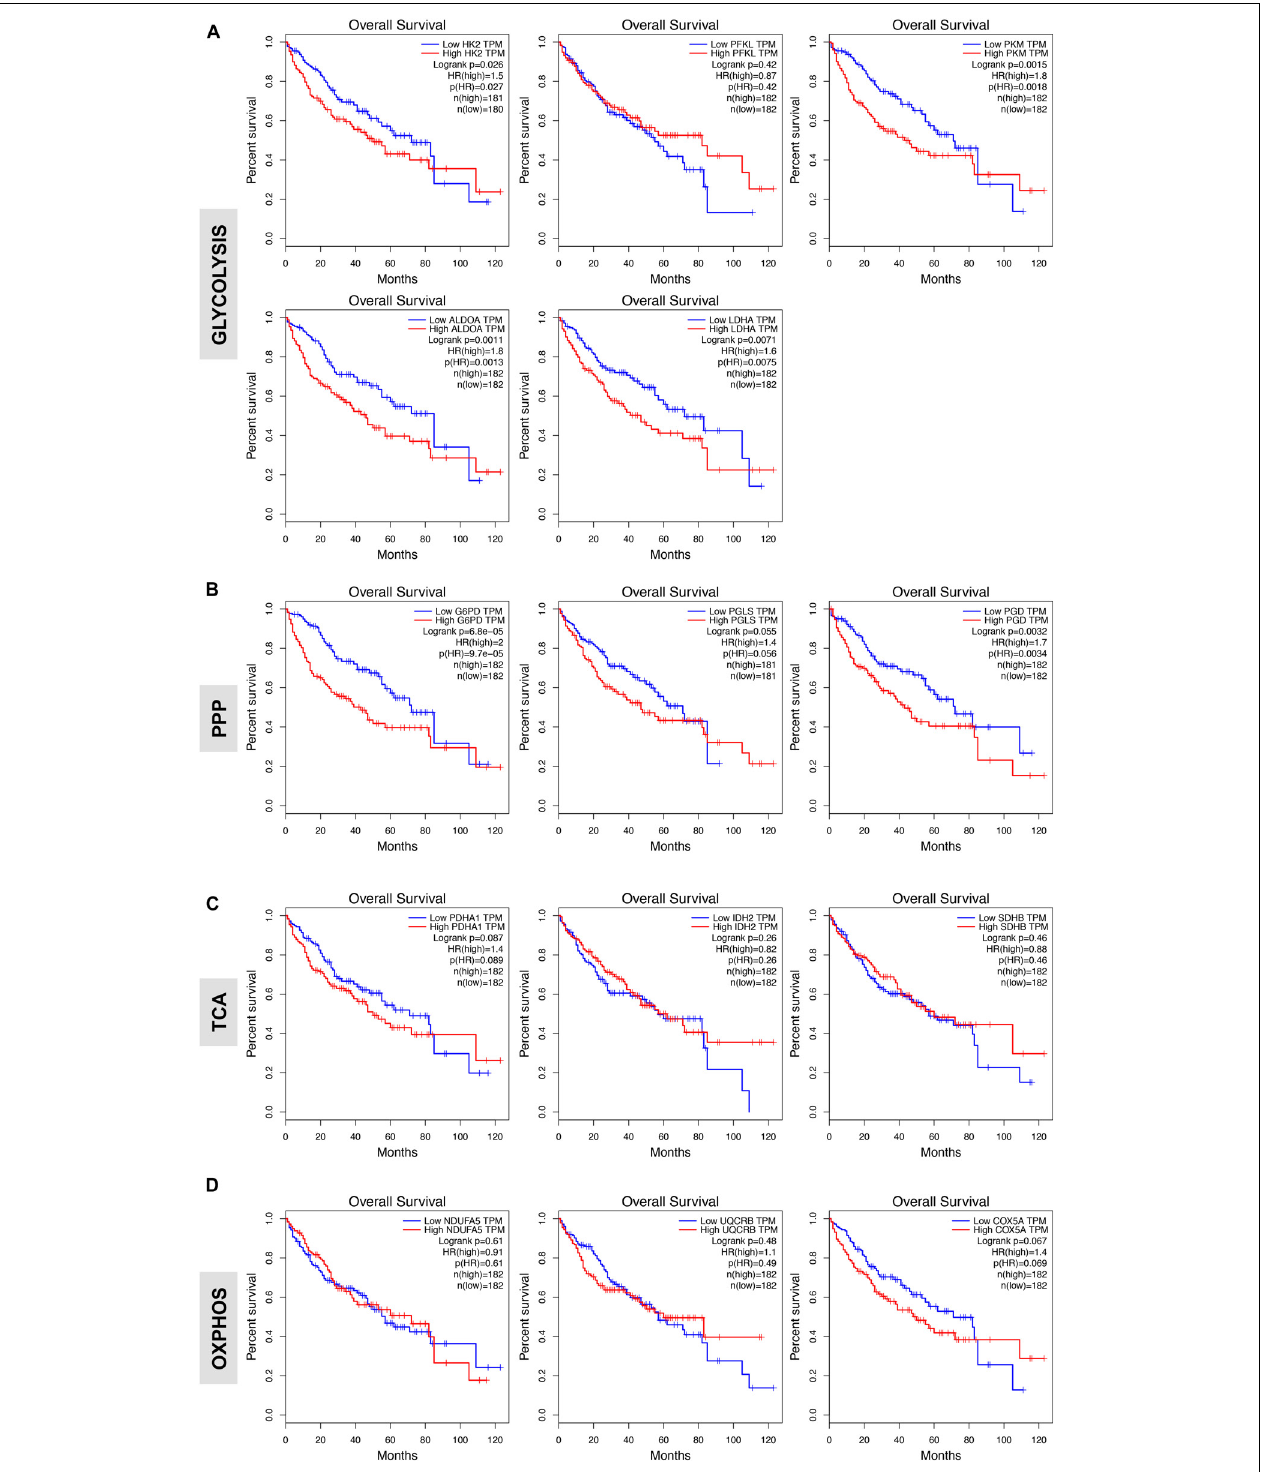
FIGURE 4 | Glycolytic gene expression is associated with poor patient prognosis. (A,B) High expression of genes associated with glycolysis and oxidative phase of PPP significantly correlates with poor overall patients’ survival. Shown are the Kaplan-Meier overall survival curves of HCC patients according to the designated gene expression levels above or below the median value based on TGA-LIHC data set and analyzed with the GEPIA bioinformatic tool of genomic database (Ally et al., 2017; Tang et al., 2017). (C,D) Kaplan-Meier overall survival curves of HCC patients in TGA-LIHC data set showing homogenous prognostic significance of TCA and OXPHOS